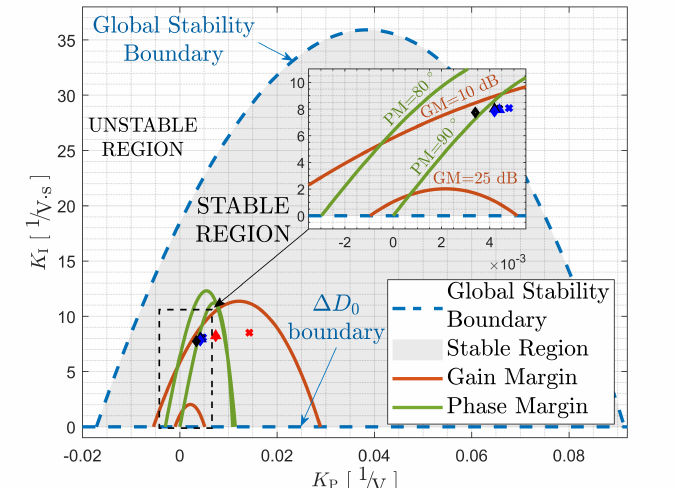
Figure 7. Visualisation of the global stability boundary and selected GM and PM trajectories, ( s ) transfer function with closed loop GM ∈ (cid:104) 10;25 (cid:105) dB and PM ∈ (cid:104) 80;90 (cid:105) ◦ , calculated for P sim,est,c2o Boost control structure shown in Figure 6. The trajectories have been calculated according to Equations (22) to (25). The red, blue and black points represent the selected in Section 4 gains with unconstrained GA, global stability constrained GA and the GM & PM constrained GA respectively. The cross, triangle and diamond stand for the IAE, ITAE and ISTAE